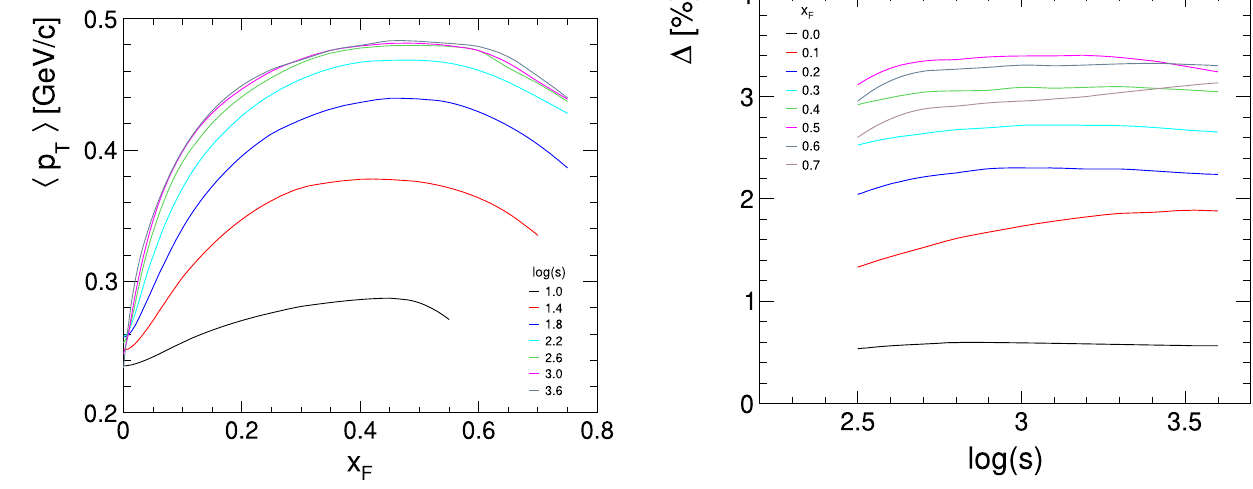
Fig. 178 The increase of (cid:4) p T (cid:5) between an upper integration limit at 1.3 GeV/c and a limit at 1.9 GeV/c in % as a function of log ( s